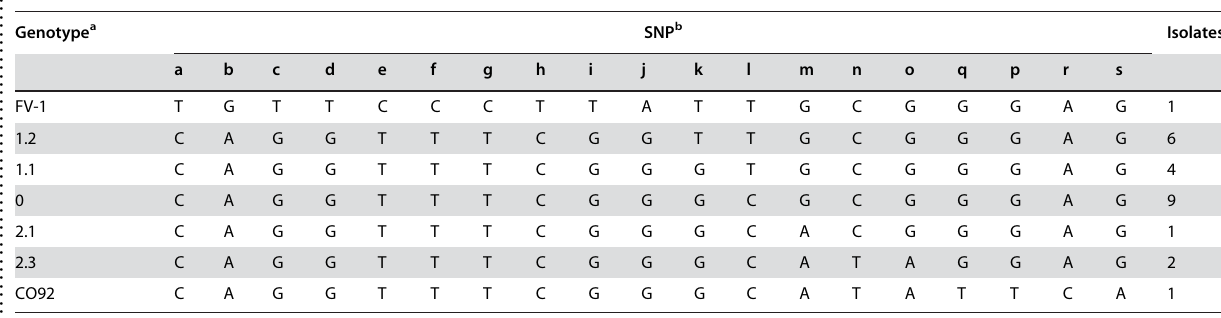
Table 3. Seven SNP genotypes identified in this study. .. ... .... ... ... .... ... ... .... ... ... .... ... ... .... ... ... .... ... ... .... ... ... .... ... ... .... ... ... .... ... ... .... ... ... .... ... ... .... ... ... .... ... ... . Genotype